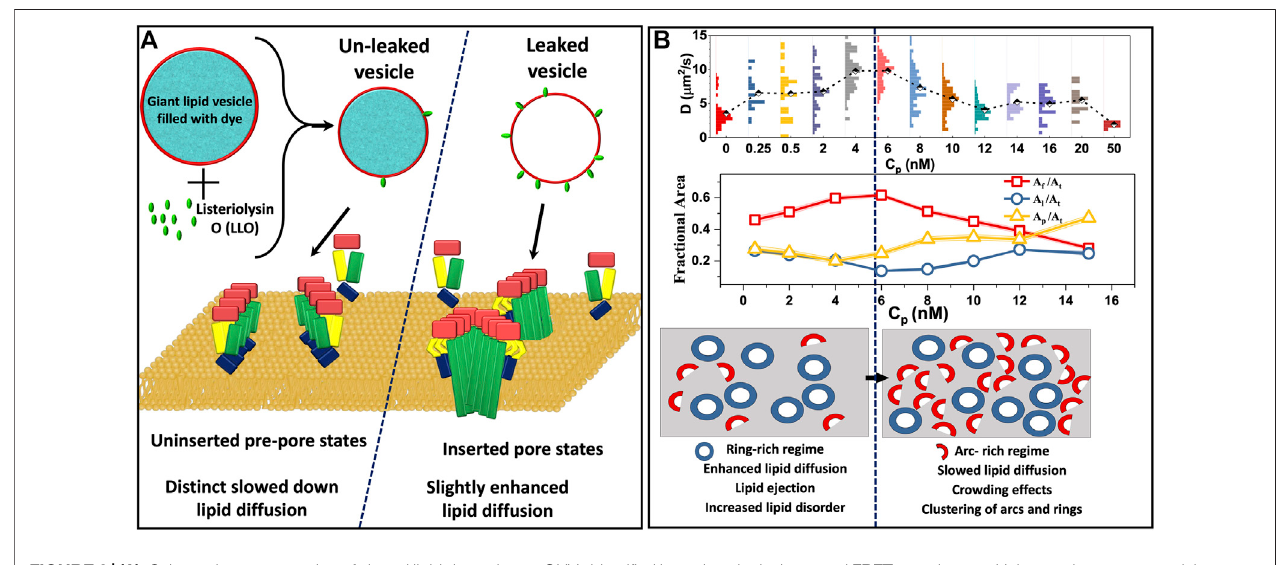
FIGURE6|(A) .Schematic representation ofaltered lipiddynamicson GUVsidenti fi ed based ontheleakage and FRETexperiments. Uninsertedprepores result in slowed lipid diffusion whereas inserted pores are found to enhance lipid diffusion (Ponmalar et al., 2019). (B) . Lipid diffusion coef fi cients measured as a function of LLO concentration, C p on supported lipid bilayerexperiments (top) and corresponding changes inthe lipid freearea (middle) derived using Eq.3 . A l , A f , A p and A t represent the area occupied by the lipid, free area in the membrane, area of protein and the total membrane area respectively. Using a two state model (Ilanila et al., 2021) where LLO oligomers are present as either rings or arcs, the increasing lipid diffusivity at low C p corresponds to a regime dominated by rings, and the decreasing diffusivity at higher C p corresponds to an arc-rich crowded regime (bottom) . (B) Adapted from Ilanila et al.